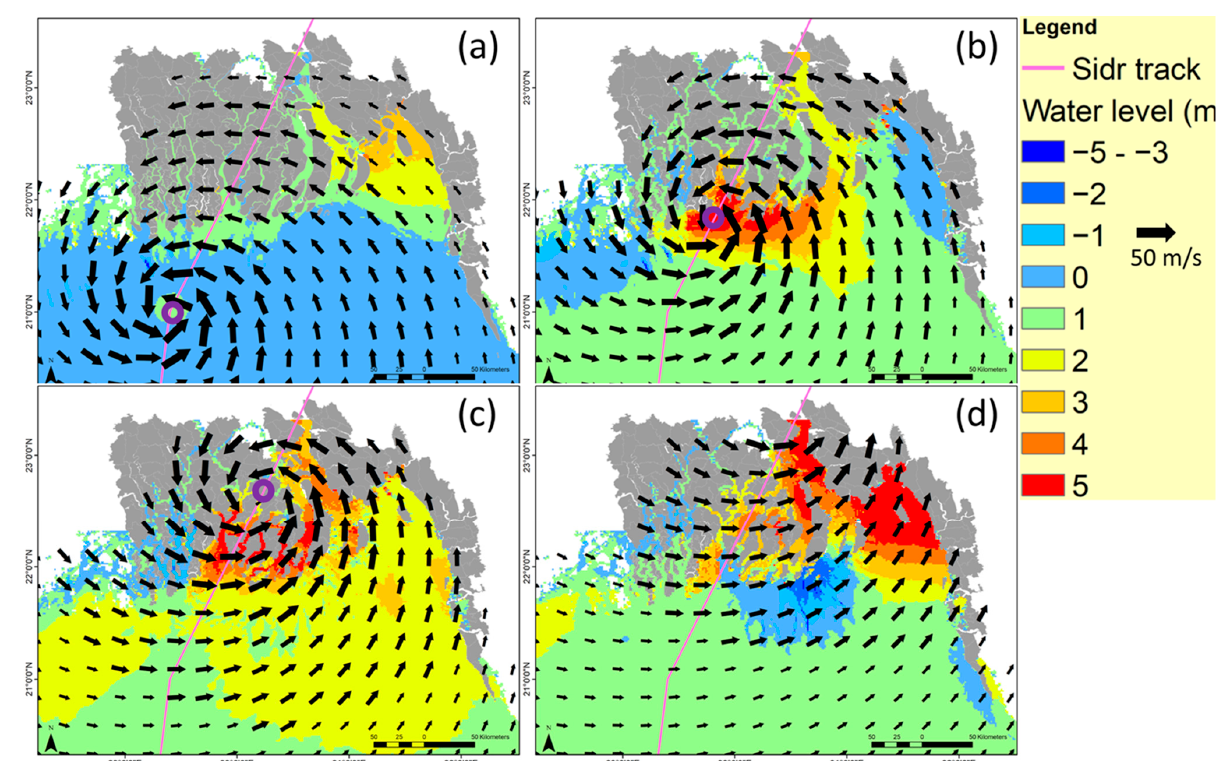
Figure 4. Model simulated spatial variations of surface water elevation (shading) and the surface wind field (black arrow) during Cyclone Sidr on 15 November 2007 at ( a ) 1200 UTC; ( b ) 1500 UTC; ( c ) 1800 UTC; and ( d ) 2100 UTC. The purple line and purple circle denote the cyclone track and cyclone eye location, respectively. The grey-shaded area represents the Bangladesh coast. In the current study, surface water elevation is defined as the total water level driven by a combined effect of tide, wind, and wave.